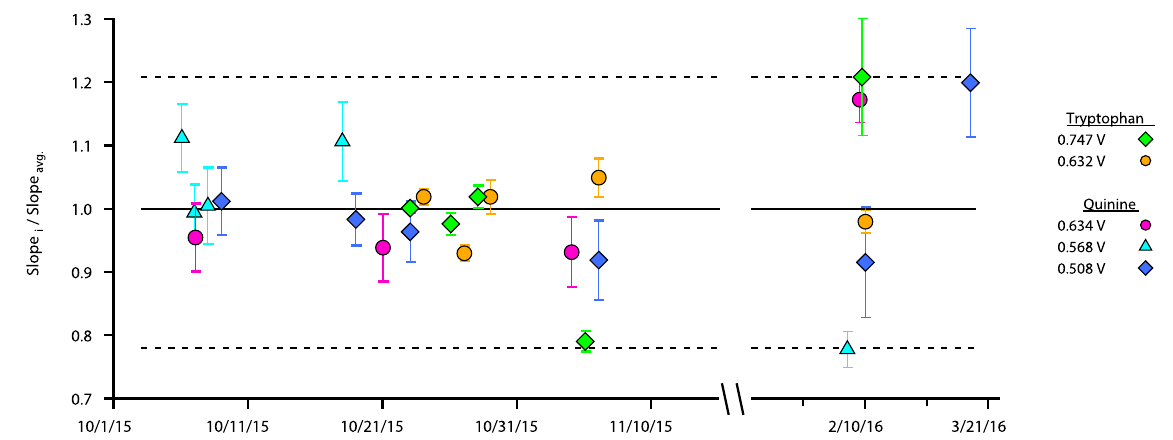
Figure 5. Normalized calibration curve slopes shown for the duration of the study for both calibration materials at each gain setting tested. The y axis is the slope of an individual experiment normalized by the average slope of all experiments of a given calibrant and gain. Error bars represent ± the standard deviation of the slope fit to each experiment. Some of the data points have been shifted by a ± 1 day to avoid symbol overlap for visual purposes. The range of all calibration experiments is ±